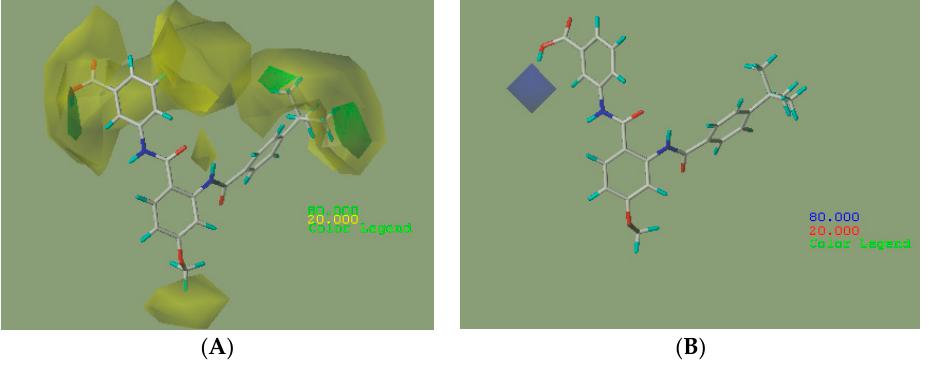
Figure 3. Contour maps of the CoMFA model: ( A ) steric field based on compound 30; ( B ) electrostatic field based on compound 30. Color values specify the CoMFA field levels that enclose volumes within which increase or decrease in bulk or positive charge favor higher dependent values.